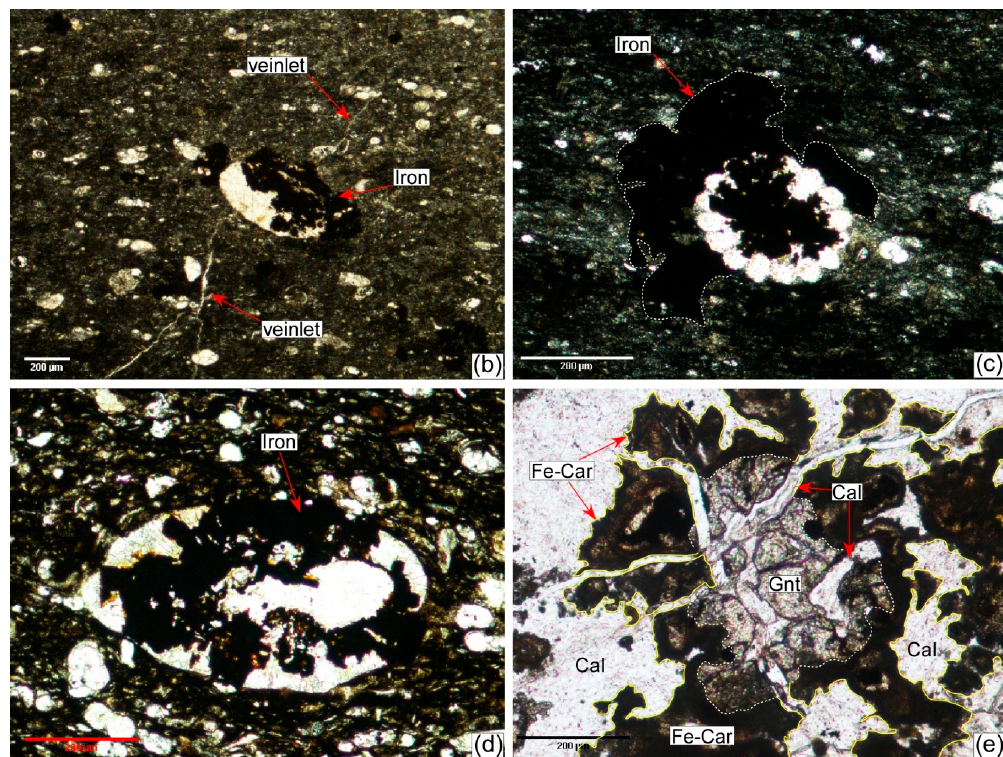
Figure 13. ( a ) Iron-rich carbonized/carbon-rich chalky limestone (wackestone to packstone) with abundant calcispheres. The iron is spatially related to the veinlets that cut through the rock. ( b ) Calcisphere partially replaced by iron that is spatially related to veinlets cutting through chalky limestone (wackestone to packstone). Iron-rich carbonized chalky limestone showing calcareous algae ( c ) and skeletal fragment ( d ) in advanced stages of iron replacement. ( e ) Corona-like texture developed in marble. Iron-rich carbonate zone developed at the contact between the garnet and carbonate. (Cal: calcite, Gnt: garnet, Car: carbonate, Fe-Car: iron-rich carbonate). Alteration of some existing phases is recognized in a few millimeter-thick zones of metasomatized basalt (Figures 11, 12, and 14). In contrast to the original basalt where the plagioclase phenocrysts are fresh to partially altered (Figure 14a, zone A), the phenocrysts in the hybrid zone are intensively saussuritized (Figure 14, zone B) implying the interaction of plagioclase with a hydrothermal solution with a significant mass transfer between the two neighboring systems. Interaction of the plagioclase phenocrysts with the calcium released from the carbonate rock into the hydrothermal solution cannot be ruled out. The latter conclusion is supported by the fact that the ground mass in the metasomatized zone is relatively coarser in grain size than the vitrophyric ground mass of the basaltic dyke, and is composed of indistinguishable calcareous constituents (Figure 14, zone B).